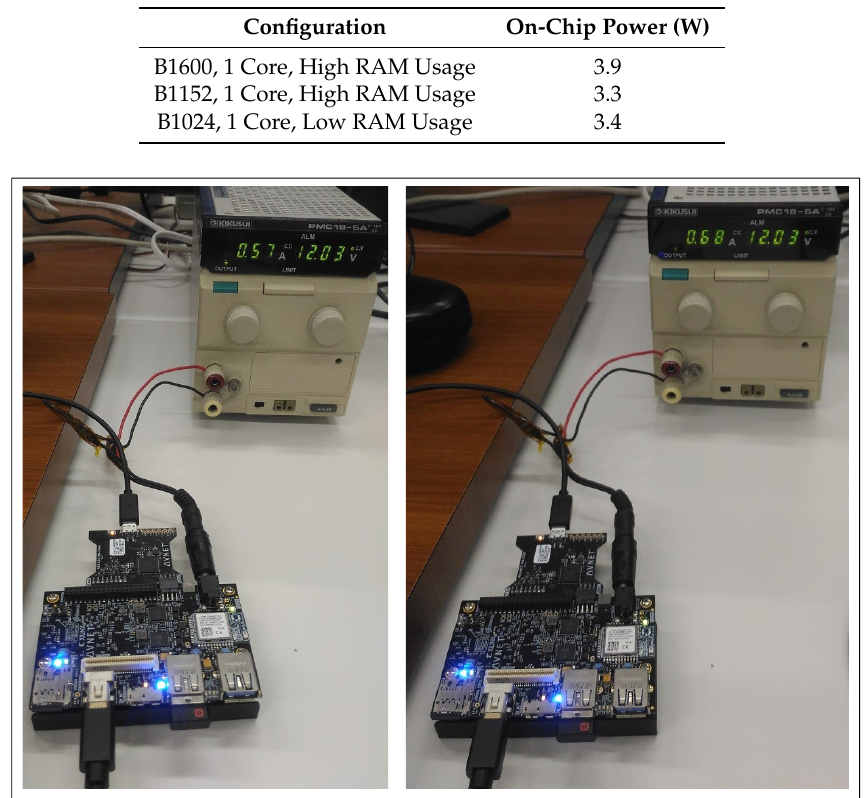
Figure 18. Power Consumption of Ultra96v2 Evaluation Board Outside and During